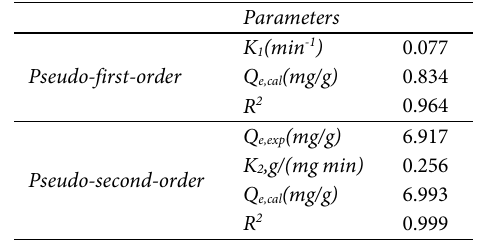
Table 1. Adsorption kinetic parameters of As(III) onto CMCD-MNPs. Table. 1. Adsorption kinetic parameters of As(III) onto CM- βCD-MNPs.